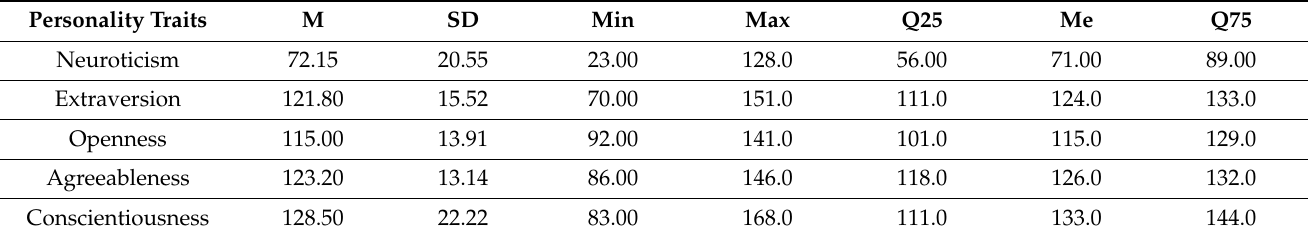
Table 3. Level of personality traits regarding the Five-Factor model among athletes training in team sports (descriptive